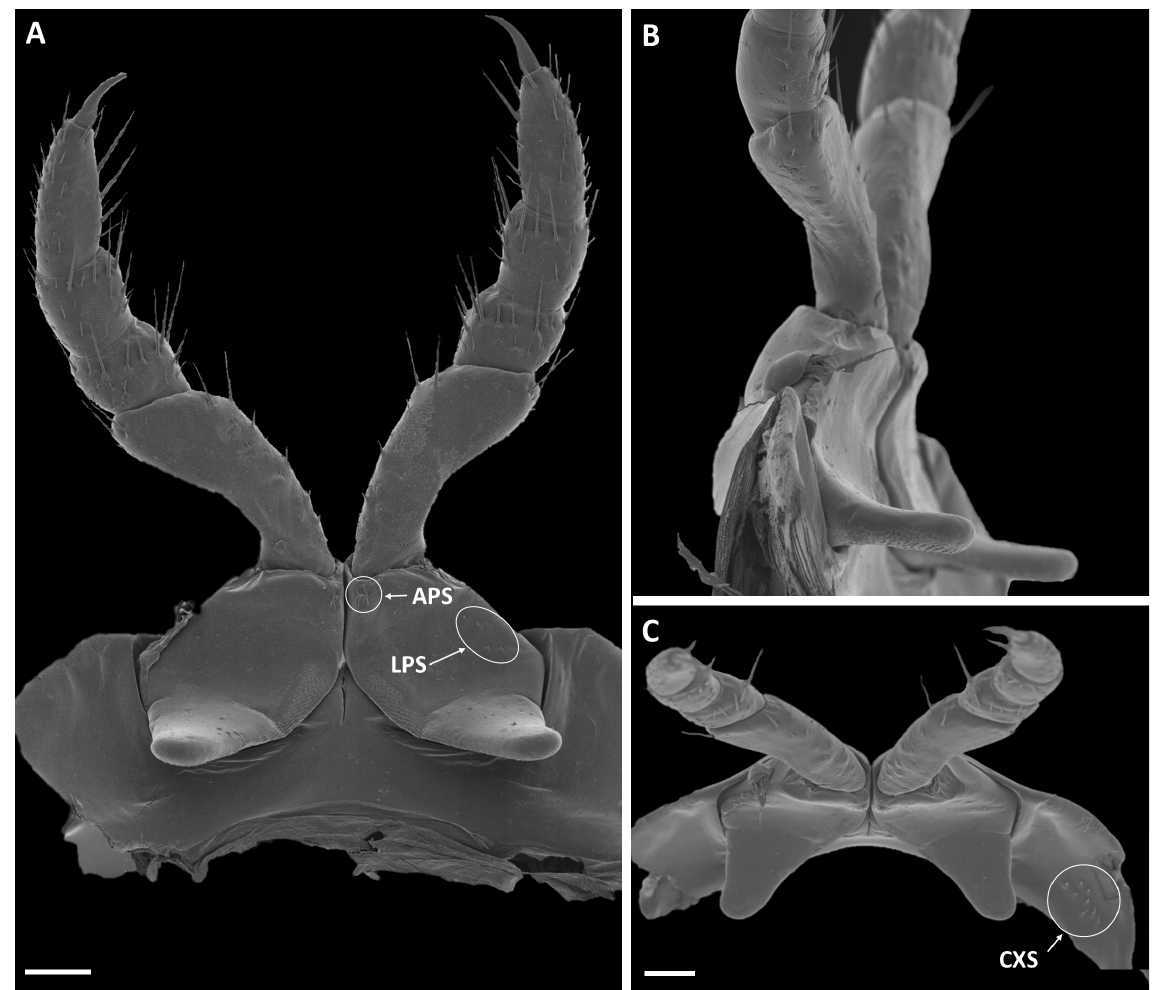
Fig. 9. Aptyctosmilax helenae gen. et sp. nov., paratype, ♂ (NHMD 621708), first pair of legs. A . Anterior view. B . Sublateral view. C . Ventral view. Abbreviations: APS = mesapical prefemoral setae; CXS = coxosternal setae; LPS = lateral prefemoral setae. Scale bars: A, C = 0.2 mm; B = 0.1